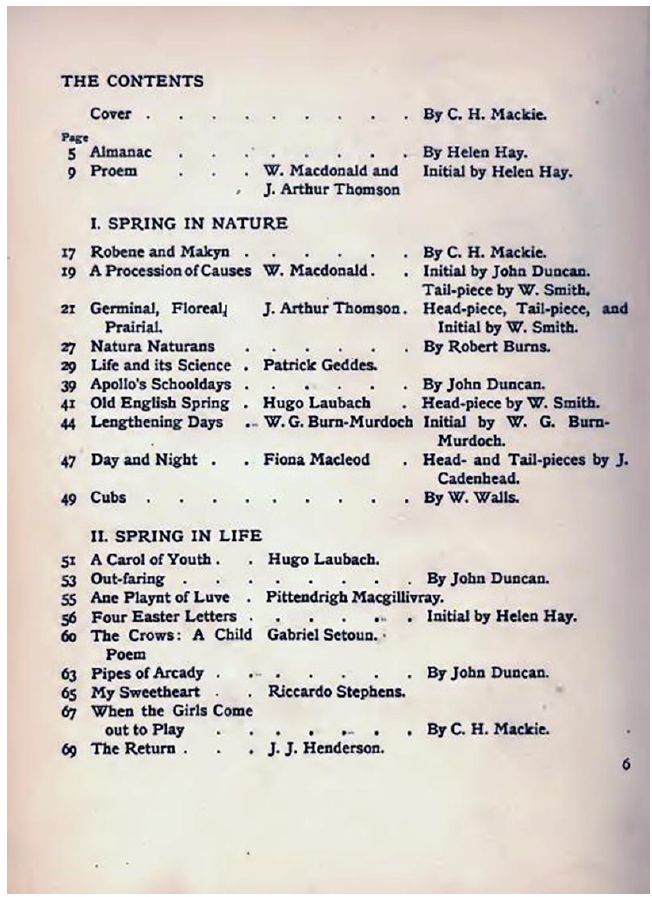
Fig. 2a Evergreen: A Northern Seasonal (Spring 1895), table of contents, private collection.